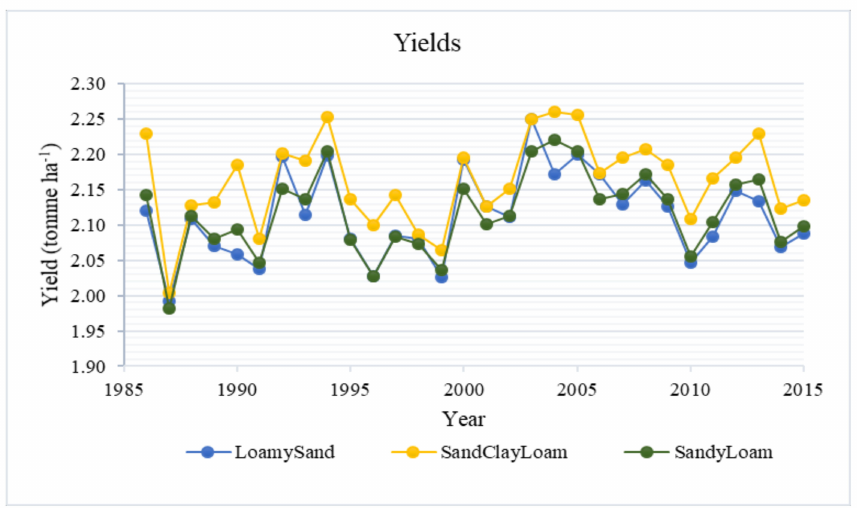
Figure 7. The change in maize